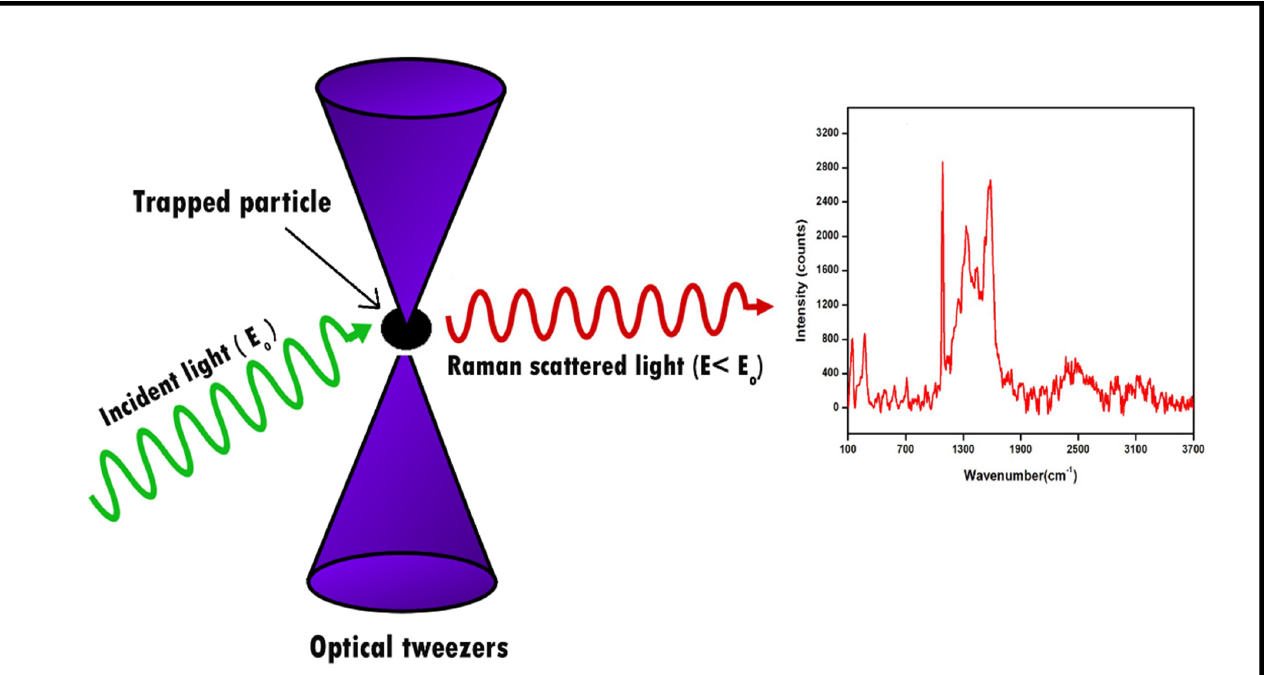
Figure 3. Schematic representation of optical tweezer/Raman system.